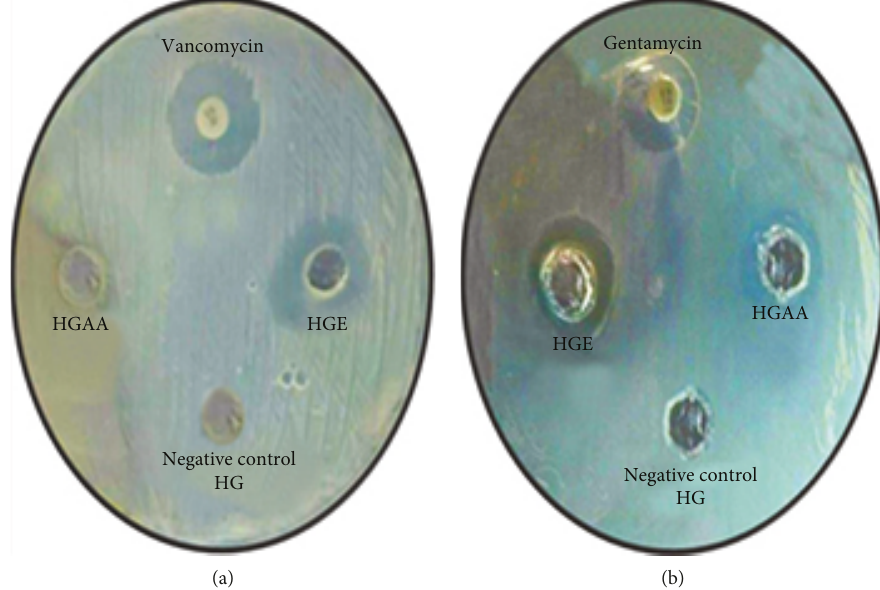
Figure 7: Inhibition zones re fl ecting the activity of the prepared hydrogels against skin pathogens: (a) against S. aureus ; (b) against P. Table 4: Inhibition zones (mm) caused by the prepared hydrogels against major skin pathogens. HGAA HE VAN GEN HG